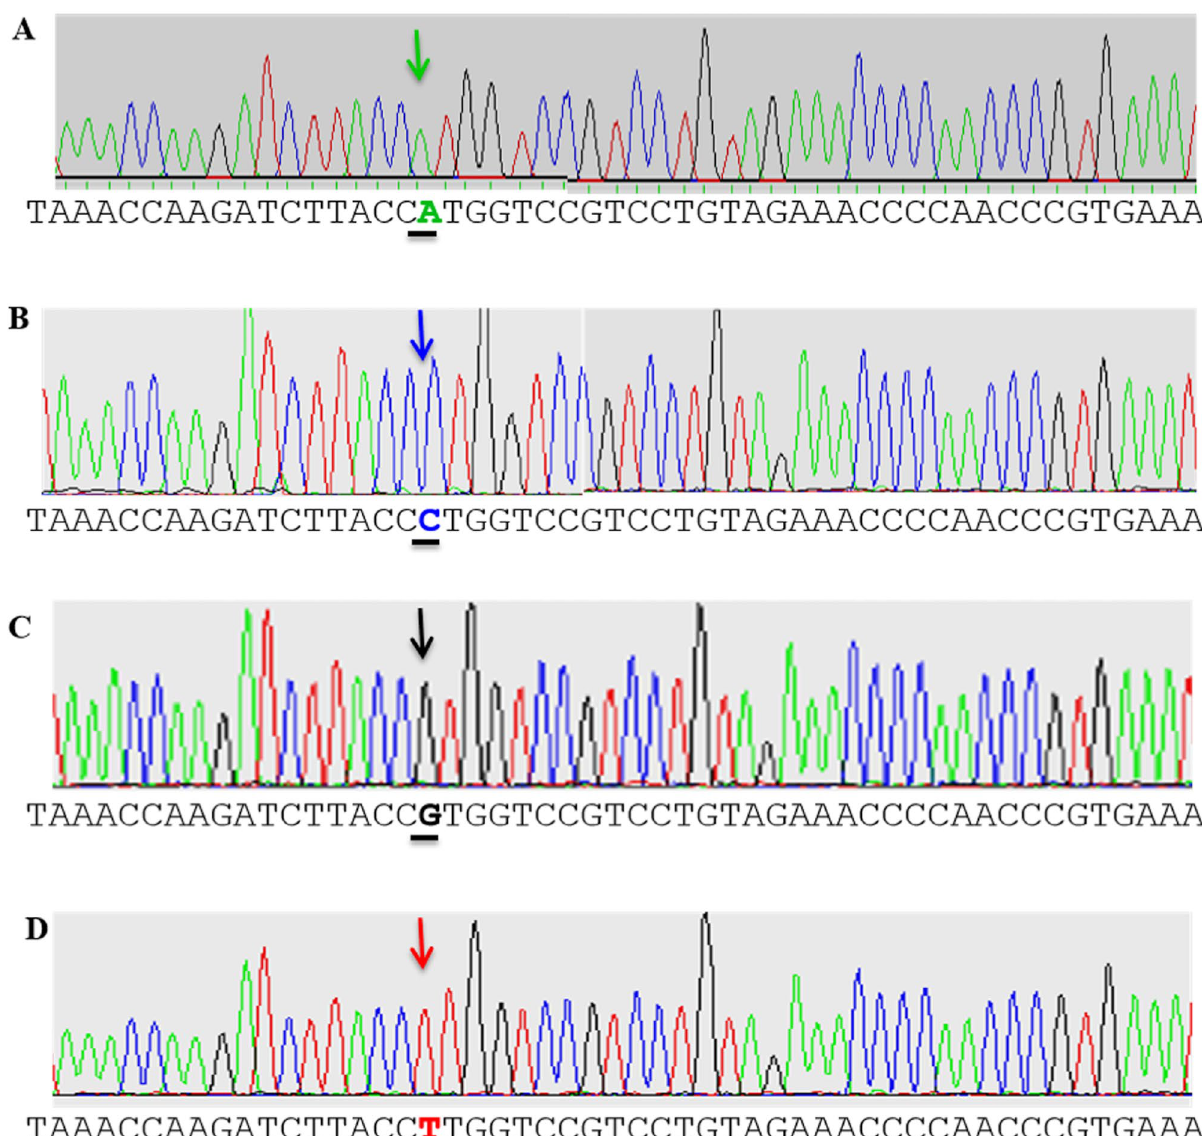
Figure 6. Partial sequence of uidA transcripts isolated from transplastomic plants that had different translation initiation start (TIS) codons. Transplastomic tobacco plants expressing psbA: uidA gene under AUG ( A ), CUG ( B ), GUG ( C ) and UUG ( D ) start codons, respectively. Sequencing data showed that the transcripts had the same base as per the gene construct in each of the transplastomic plants, ruling out any RNA editing of uidA transcripts in these